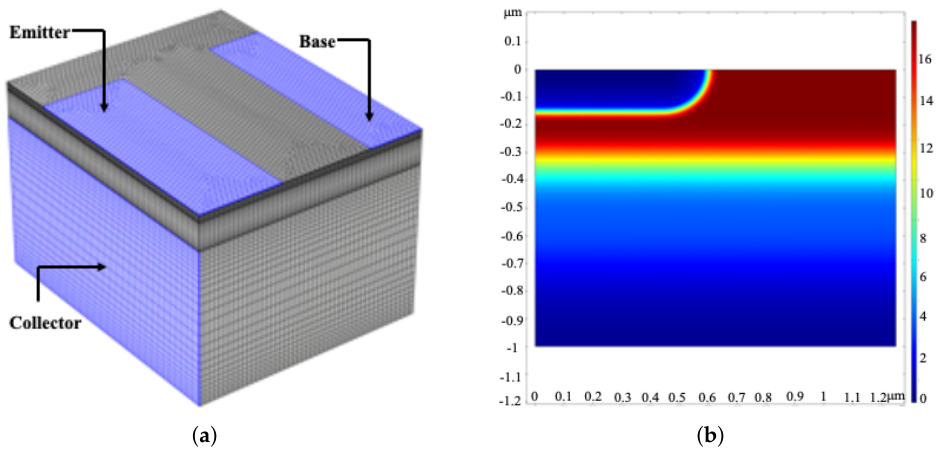
Figure 1. ( a ) The three-dimensional model of NPN bipolar transistor. ( b ) The initial potential distribution of the intrinsic semiconductor. (Two-dimensional section: x axis represents the length of the model, y axis represents the height of the model. There is no external electric field.)